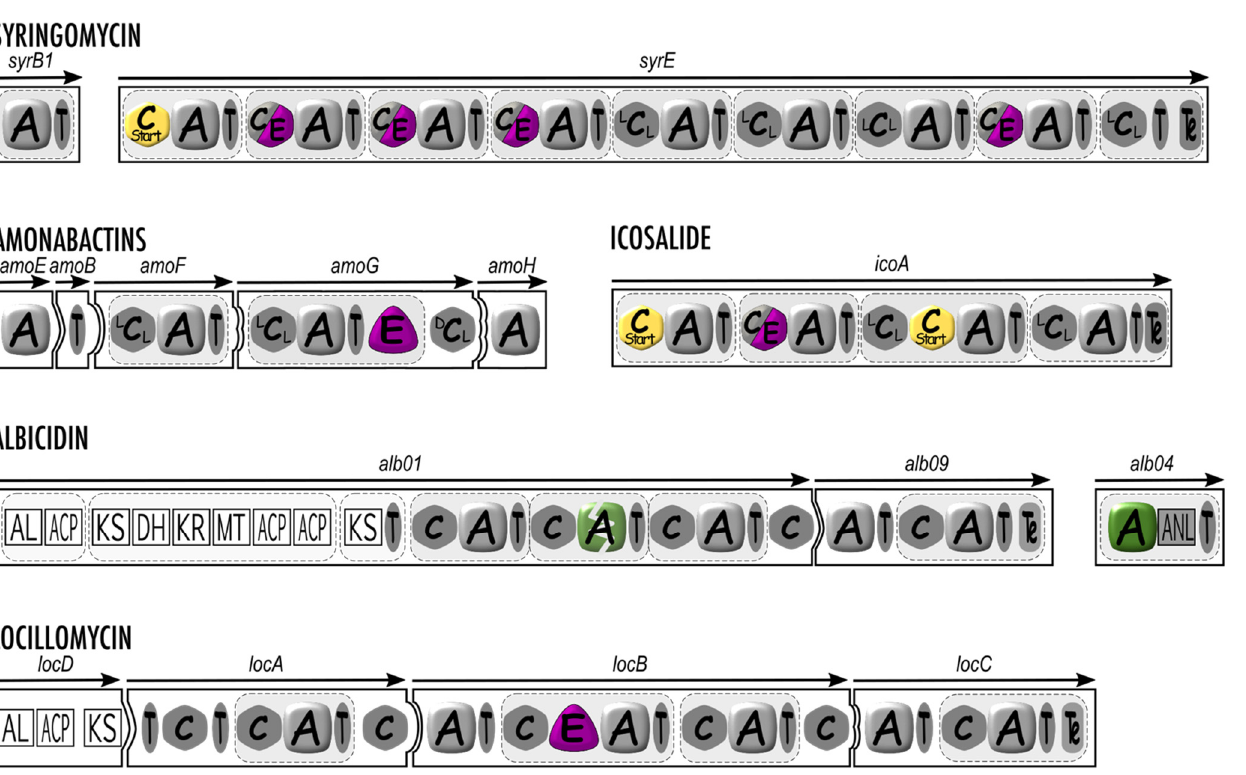
Figure 3. Structural organization of syringomycin, amonabactins, icosalide, albicidin, and locillomycin synthetases with an “out of the rules” mode of biosynthesis. A, adenylation domain; C ( L C L , D C L, or C start ), condensation domain; C/E, dual condensation and epimerization domain; T, thiolation domain; E, epimerization domain; MT, methyl transferase domain; AL, acyl-CoA ligase domain; ACP, acyl carrier protein; KS, ketosynthase domain; DH, dehydrogenase domain; KR, ketoreductase domain; ANL, α -ANH-like domain. The nonfunctionnal second A domain of albicidin synthetase is depicted with a green broken rounded square. The white squared domains are related to PKSs.